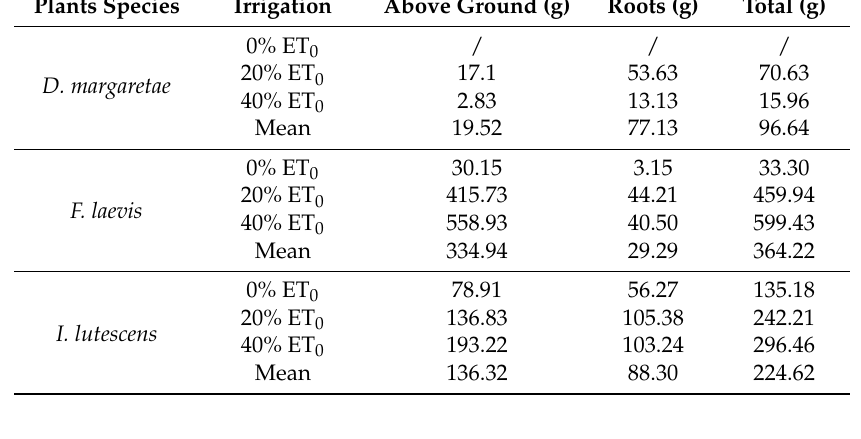
Table 3. Means of dry weight (g) × m 2 of the tested species in the three irrigation protocols. Plants Species Irrigation Above Ground (g)